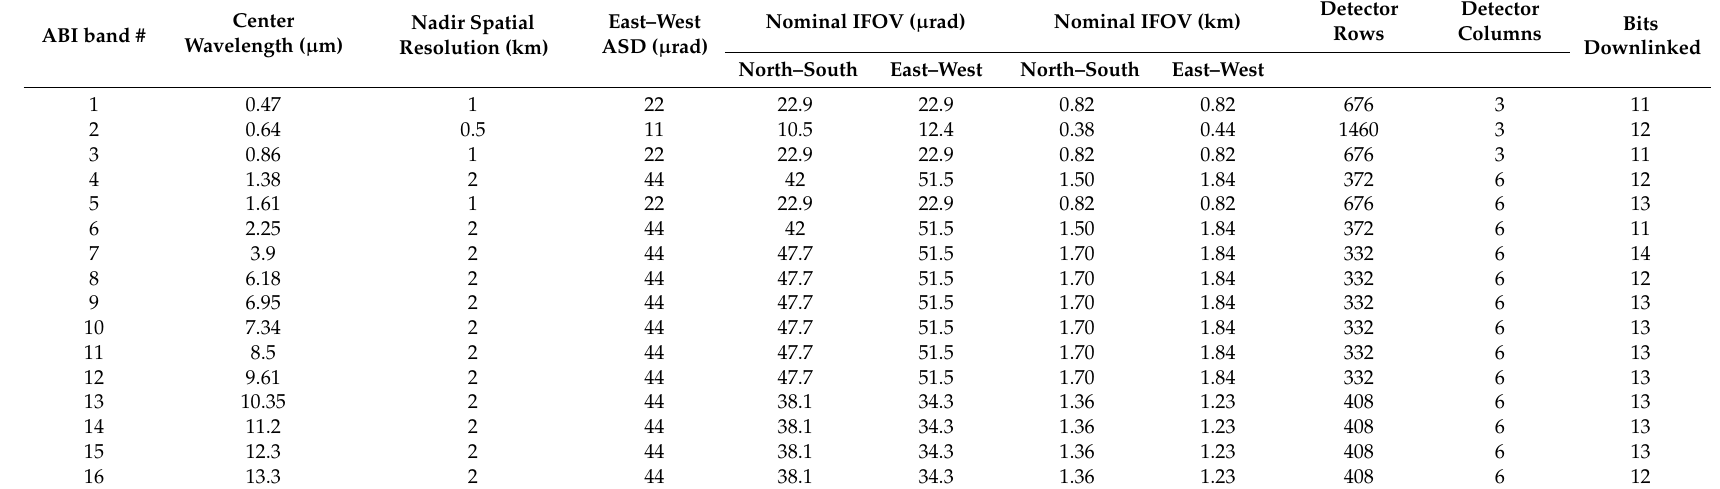
Nominal IFOV (km)